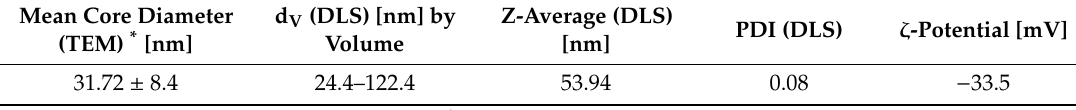
Table 1. Compilation of characteristics of MCP 3 as determined by TEM and DLS.